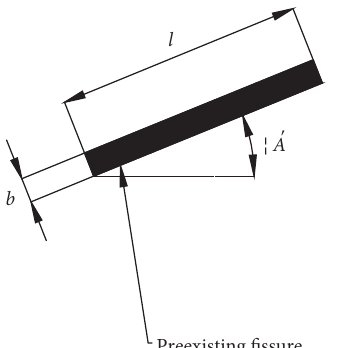
Figure 2: Dimensional drawing of the specimens and prefabricated